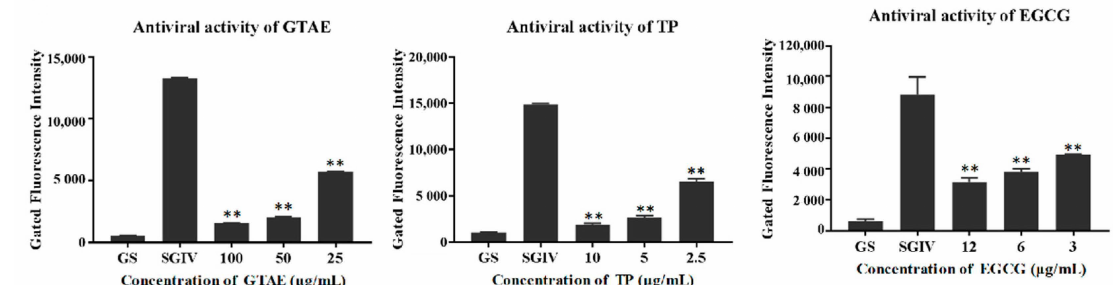
Figure 6. Antiviral activities of green tea components against SGIV evaluated with Q5c-AFMP at 48 h. GS cells incubated with SGIV and the diluted green tea components (GTAE at 100, 50, or 25 µ g/mL; TP at 10, 5, or 2.5 µ g/mL; and EGCG at 12, 6, or 3 µ g/mL) constituted the test groups. GS cells infected with SGIV only constituted the positive control group. Antiviral effects were analyzed as the fluorescence intensity of cells. ** indicates p <